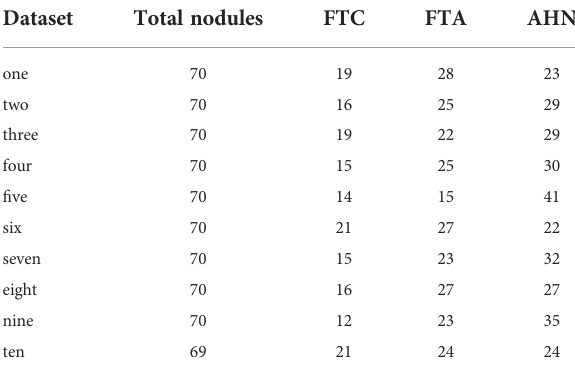
TABLE 2 The subdivided datasets for subsequent nodular diagnosis experiment.